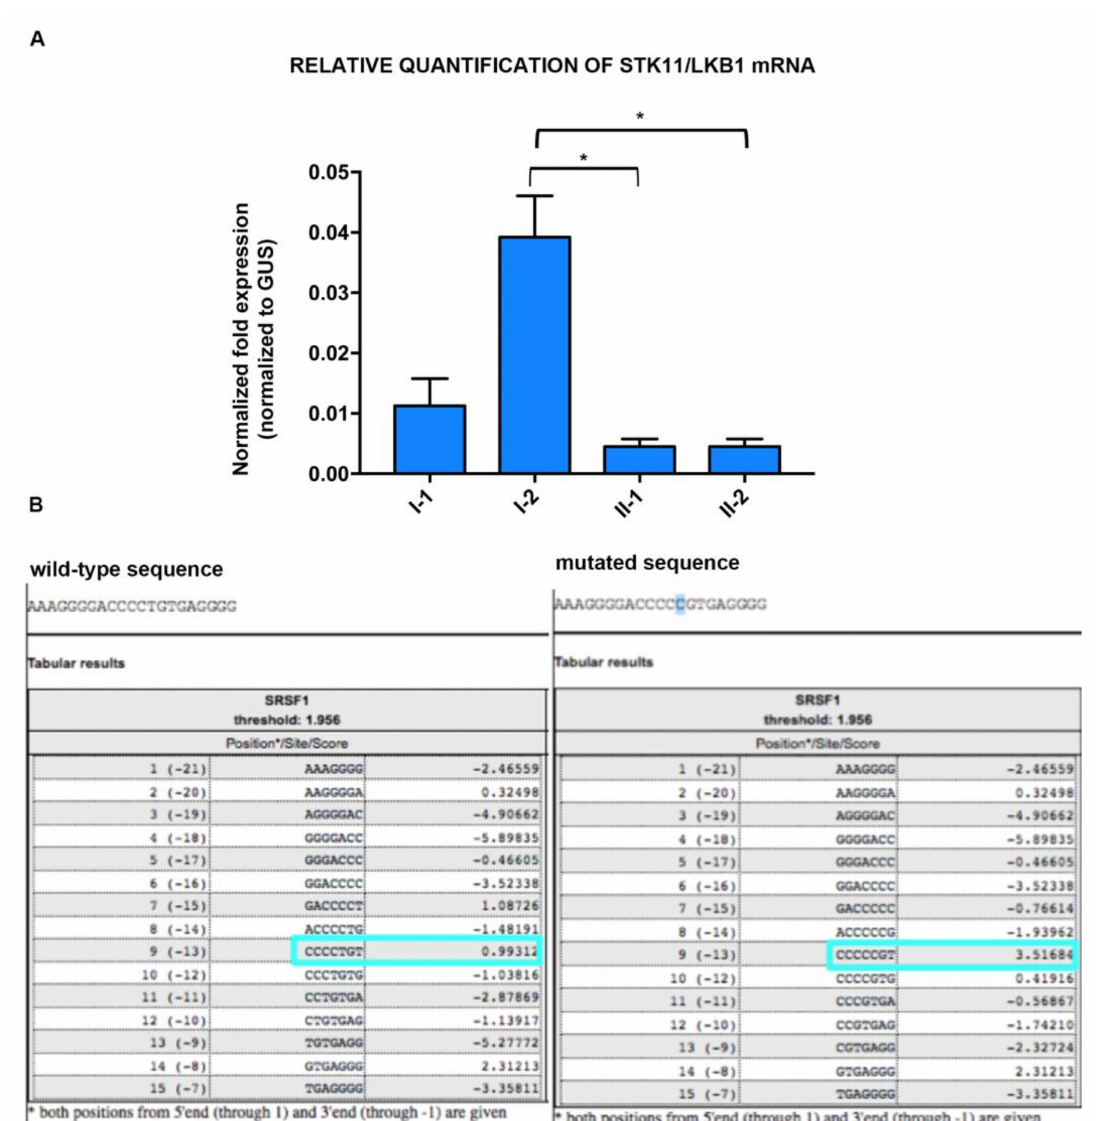
Figure 4. Potential role of the c.465-51 T → C SNP. ( A ) Real-Time PCR of STK11 mRNA; Bar graphs represent mean ± SEM (three independent determinations) of normalized STK11 expression to glucuronidase mRNA (Dct); *: significance level of p < 0.05 vs. healthy subject I-2; repeated measures multiple comparisons Kruskal–Wallis test one-way ANOVA has been used for the analysis. I-1, I-2, II-1 and II-2: subjects of PJS family as reported in pedigree of Figure 2A. ( B ) ESEfinder in silico analysis of STK11 c.465-51T → C variant in intron 4 showing activation of a binding site for the serine / arginine-rich splicing factor (SRSF1) splicing factor. The light blue boxes indicate SRSF1 protein binding score calculated for wild type and mutant